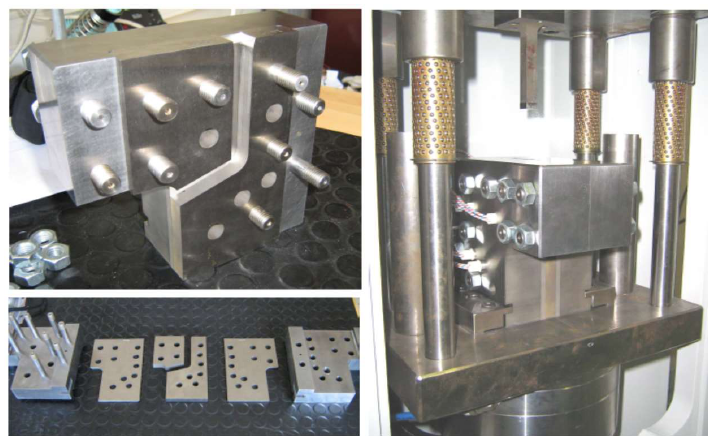
Figure 34. ECAP tool used for SPD treatments to Mg alloys, as developed by POINSARD Design and Tool SAS (Besançon, France). Up and left: the open channeling die, down-left: tools forming different angle channels, E = 95°, 105°, 115°, 125°, and 135°, right: ECAP system (die, punch) [36].